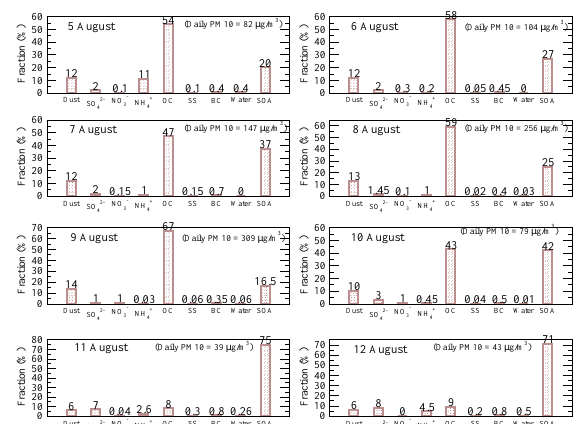
Fig. 4. Daily mean percent distribution of the different chemical species to the total PM10 concentrations at thesurfacemodelled at Moscowforeachday ofthe studied period (SS:Sea Salt). Daily mean values of the total PM10 surface concentrations (in µ g/m 3 ) are indicated in parenthesis.